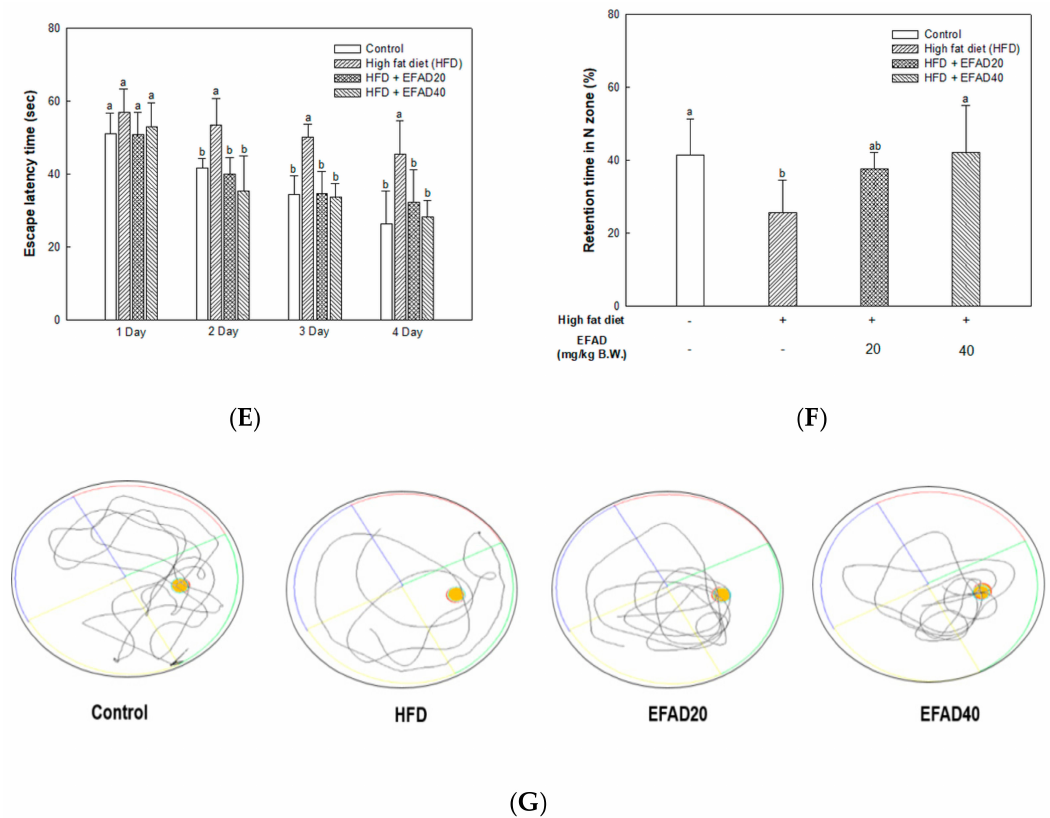
Figure 3. E ff ect of ethyl acetate fraction from Aruncus dioicus var. kamtschaticus (EFAD) on cognitive dysfunction induced by High fat diet (HFD). ( A ) Alternation behavior. ( B ) Number of arm entry. ( C ) Three-dimensional (3D) data of tracking path in Y-maze test. ( D ) Step-through latency time measured by passive avoidance test. ( E ) Escape latency time from one day to four day. ( F ) Retention time in N zone. ( G ) Travel trajectories measured in Morris water maze test. The values shown are as mean ± SD ( n = 7). The data were statistically considered at p < 0.05 and they were represented as di ff erent small